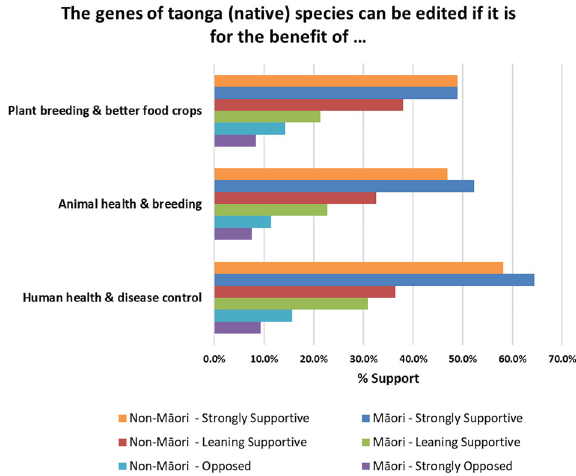
Fig. 7 Support for M ā ori values in guiding decisions about GEd among non-M ā ori respondents byclusters. Non-M ā ori respondents in two of the three cluster perspectives – Leaning Supportive and Opposed – believe that M ā ori values are not important in guiding decisions about the use of GEd. However, Non-M ā ori who are Strongly Supportive of genetic technologies believe M ā ori values are important in guiding decisions about the use of GEd. The M ā ori value of Whanaungatanga (kinship) is shown in orange,Mauri (life force) light blue, Mana (spiritual power) purple; Taonga species(native species) green, Whakapapa (genealogy) red, and Kaitiakitanga (guardianship) dark